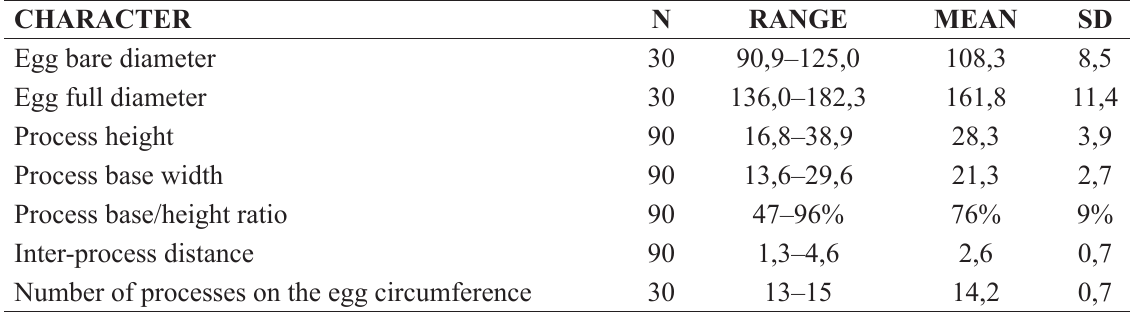
Table 5. Measurements (in μm) of selected morphological structures of the eggs of Tenuibiotus zandrae sp. nov. mounted in Hoyer’s medium (N: number of eggs/structures measured; RANGE refers to the smallest and the largest structure among all measured specimens; SD: standard